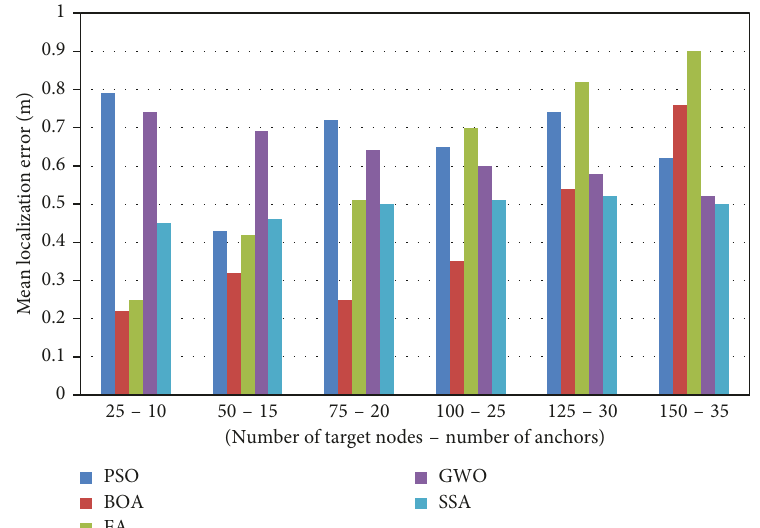
Figure 4: The localization error of the different localization algorithms in different WSN deployments.